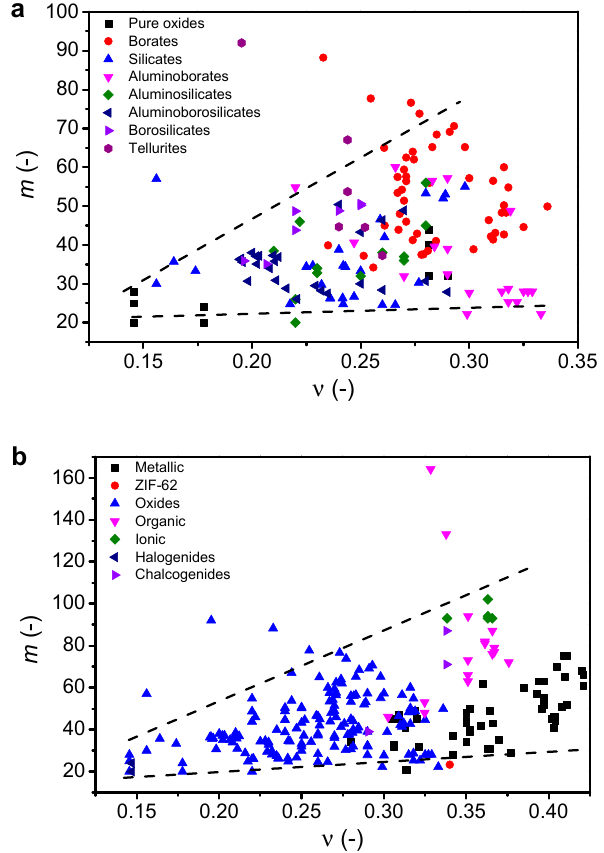
Figure 5. Liquid fragility ( m ) as function of Poisson’s ratio ( ν ) for ( a ) oxide glass-formers (including both present compositions from Table 1 and literature data) and ( b ) various glass-formers from literature. References for literature data are given in the text. The dashed lines are guides for the eye, showing the trends for the majority of the data. The errors associated with m and ν are 1 and 0.01, respectively. R 2 values for linear fits to the data are 0.078 and 0.178 for ( a ) and ( b ), respectively.